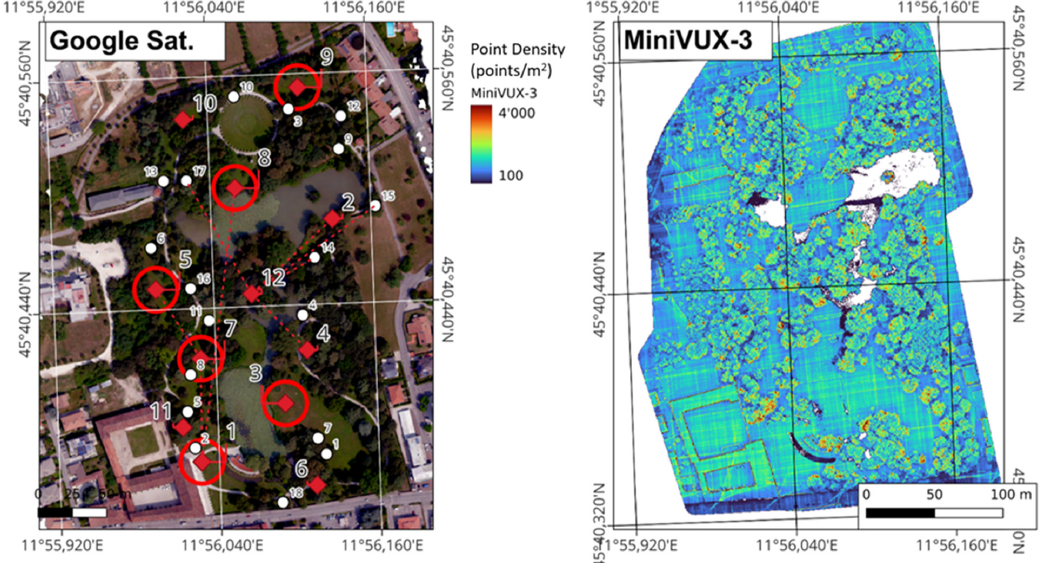
Figure 4. Left is the birds-eye view of the garden of Villa Revedin Bolasco with ground control points (red double circle) and check points (white circle); right is the density map of points.